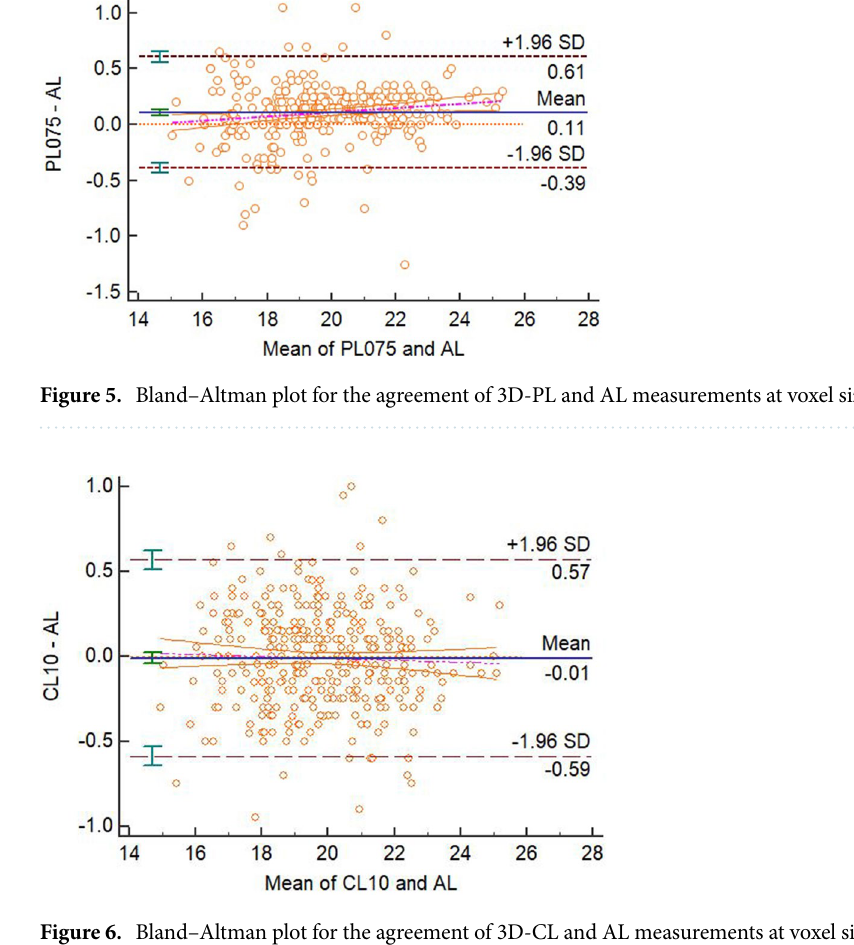
Figure 6. Bland–Altman plot for the agreement of 3D-CL and AL measurements at voxel size of 0.10.